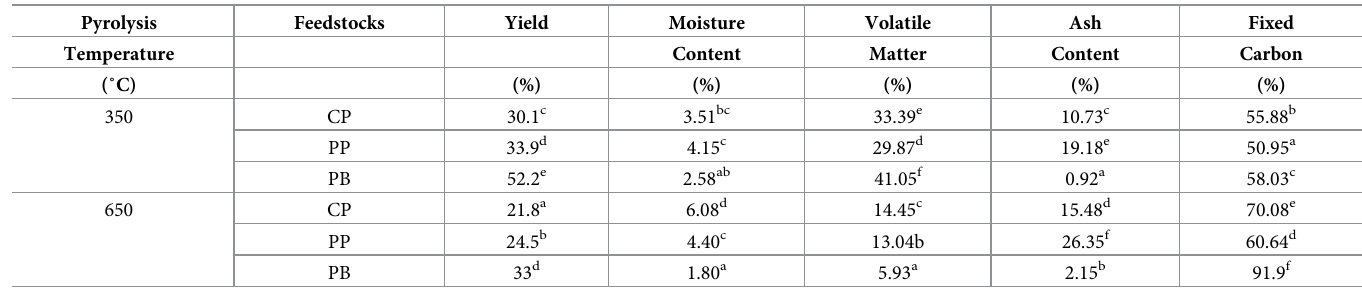
Table 3. Yield and proximate analysis results of the